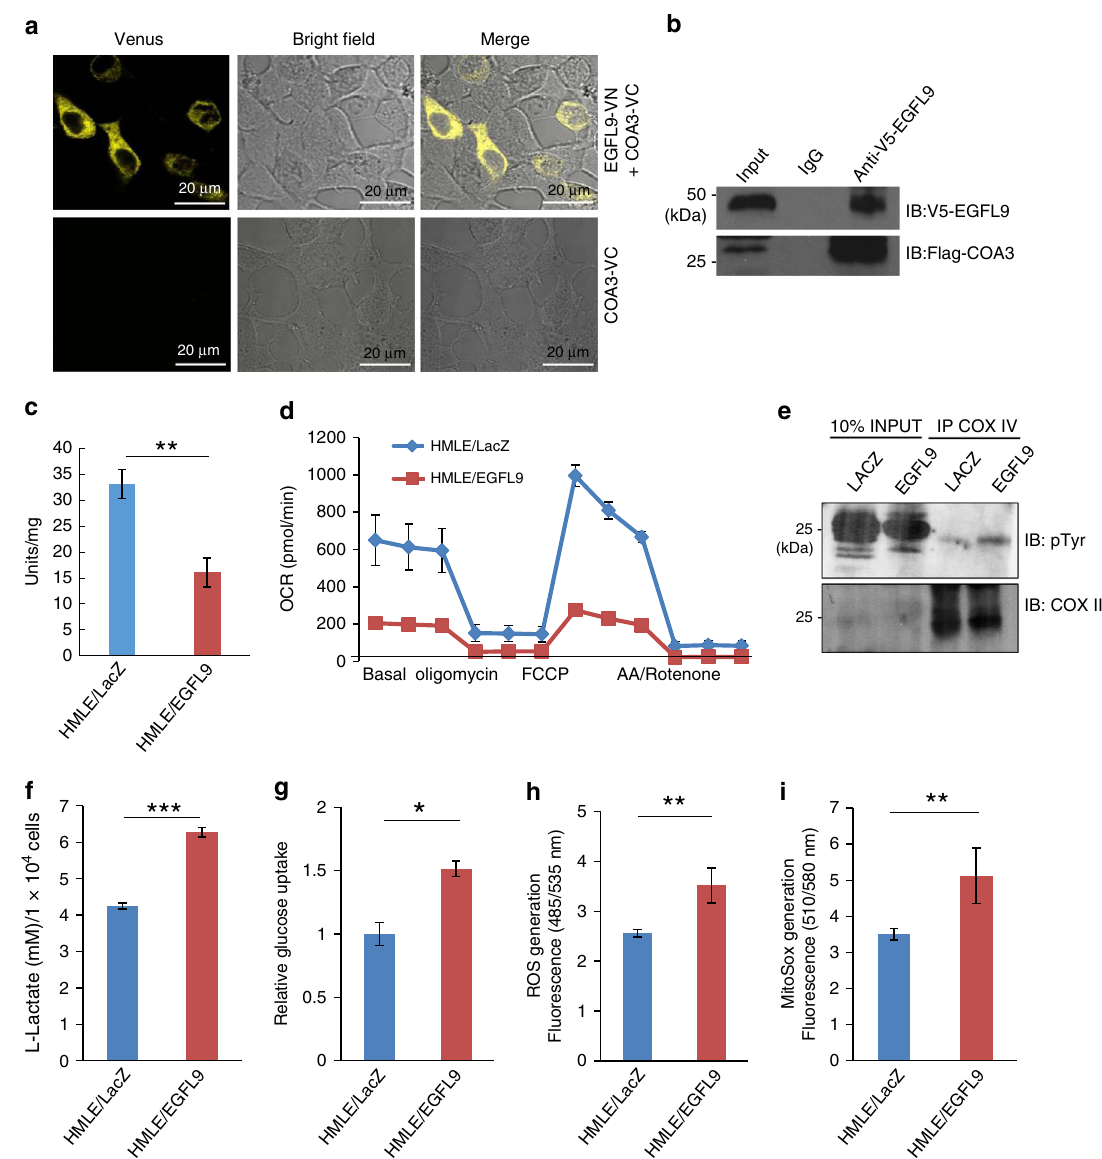
Fig. 7 EGFL9 regulates cellular metabolism. a Visualization of EGFL9-COA3 interaction in vivo by BiFC live-cell imaging performed in 293 T cells. The top panels show 293 T cells transfected with p3xFlag-CMV-EGFL9-VN and p3xFlag-CMV-COA3-VC. The bottom panels show 293 T cells transfected with COA3-VC alone. Images of Venus (YFP), bright fi led, and merge are shown. Scale bar: 20 µ m. b BiFC result was con fi rmed by Co-IP western blot analysis. pLent-6-EGFL9-V5 and p3xFlag-CMV-COA3 constructs were co-transfected in 293 T cells. Co-IP was performed with anti-V5. Western blotting was